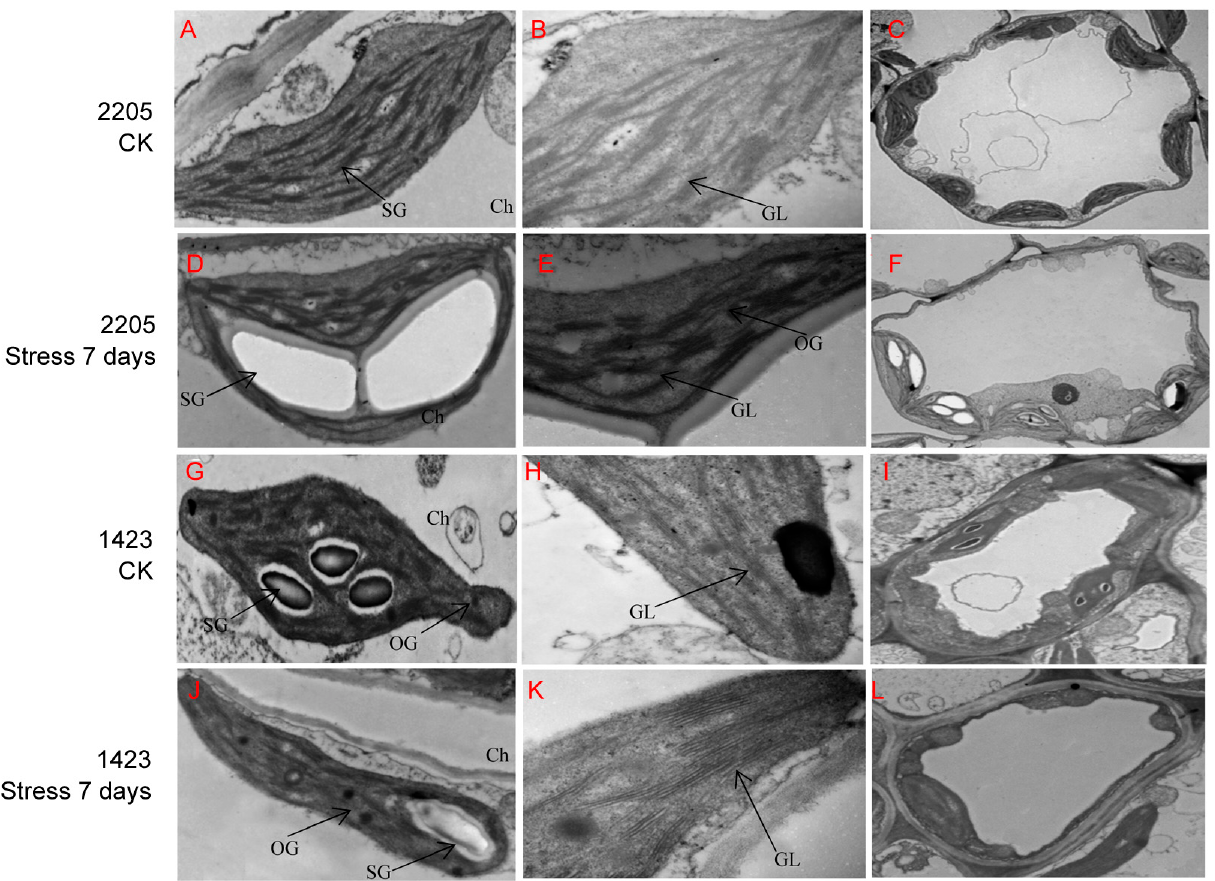
Figure 2. Ultrastructural observation of the tolerant line 2205 and sensitive line 1423 under control and NaHCO 3 stress. The ultrastructure of leaves of line 2205 ( A – C ) and line 1423 ( G – I ) without alkaline salt stress, 7 d NaHCO 3 -treated 2205 ( D – F ) and 1423 ( J – L ). Ch, chloroplast; GL, basal grains; OG, osmophilic granules; SG, starch granules.